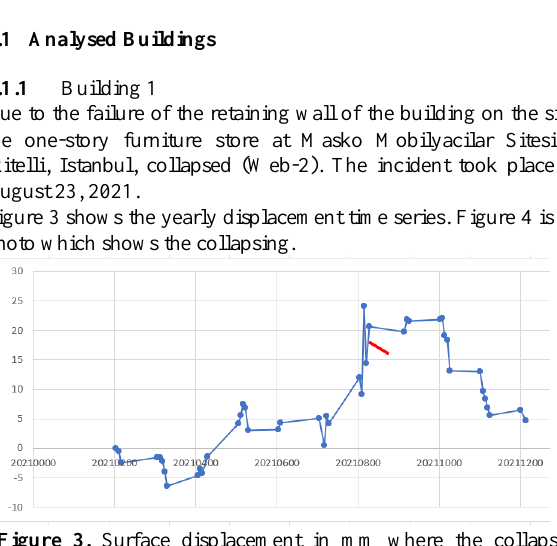
Figure 2. Annual displacement velocity calculated in Ascending mode for Istanbul City (mm/year).